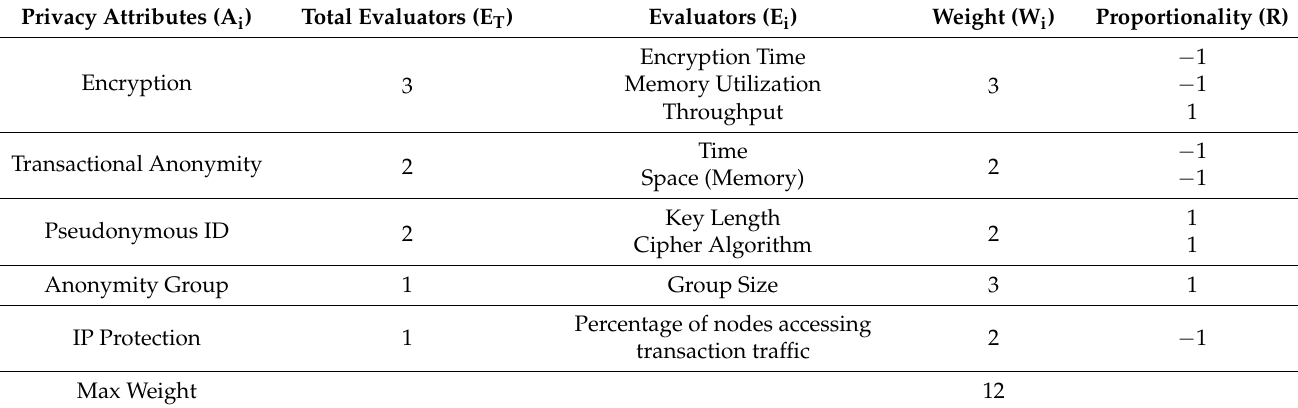
Table 5. Privacy